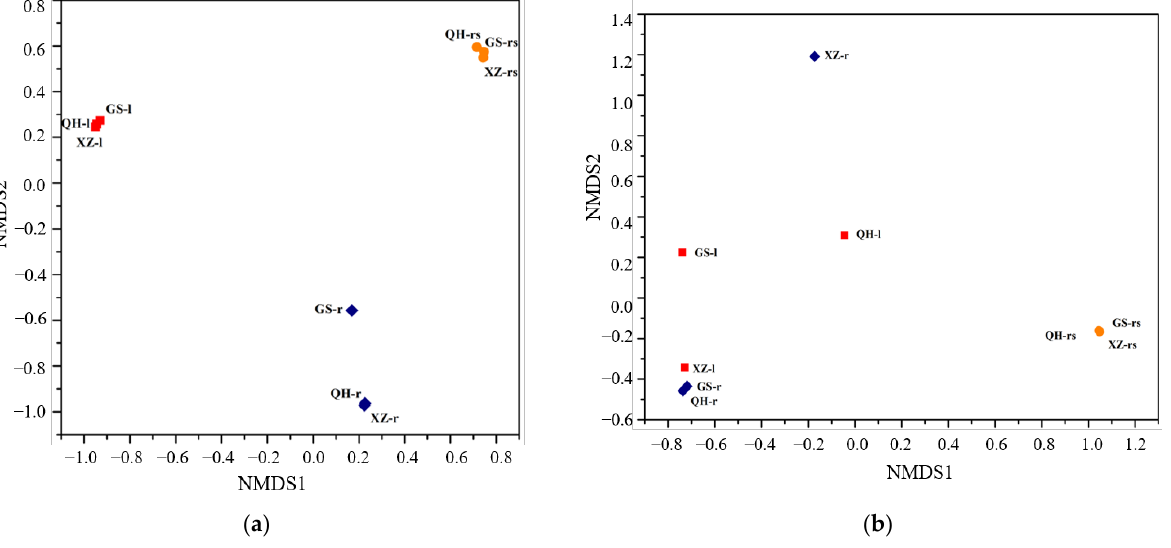
Figure 4. NMDS analysis of fungal ( a ) and bacterial ( b ) communities in rhizosphere soil, root and leaf of S . purpurea in different sampling sites.